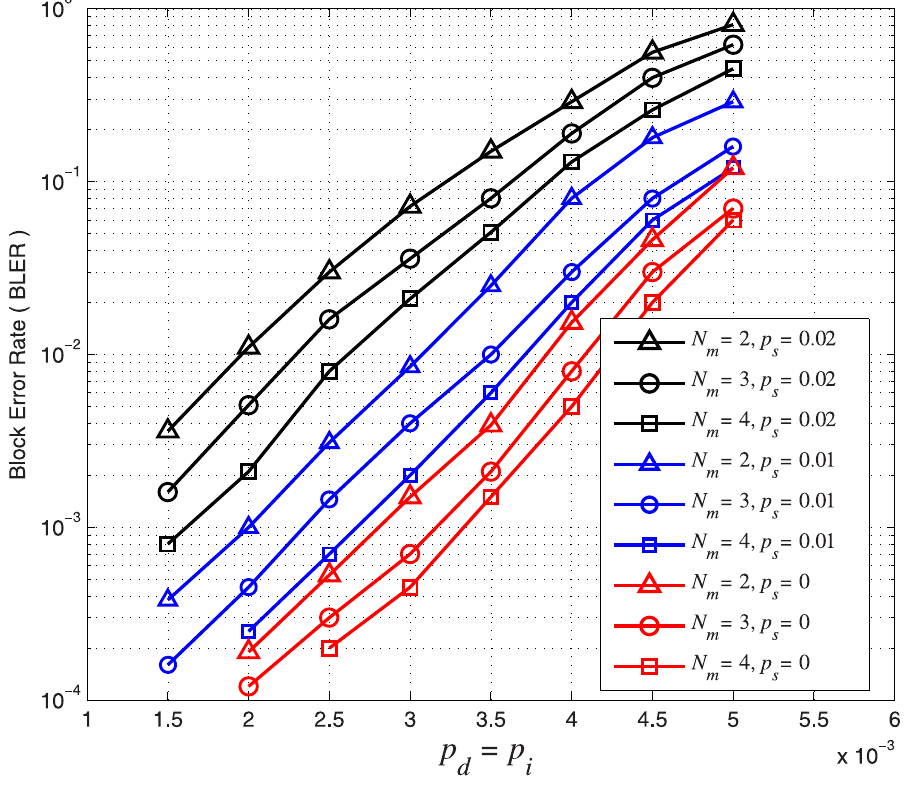
Fig 9. BLER of the concatenated LDPC-marker code over the CID channel. N c = 18 and N m = 2, 3, 4.